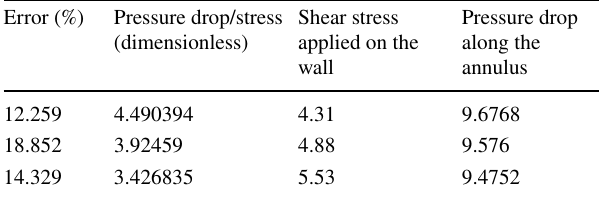
Table 5 Simulation error % (reproduced with permission from Jiimaa 2014) Error (%) Pressure drop/stress (dimensionless)